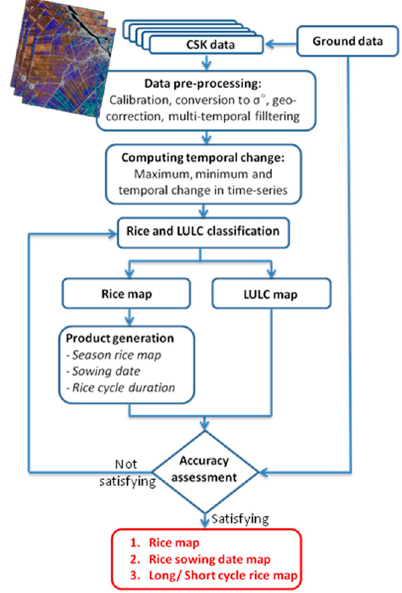
Figure 10. Flowchart of the rice monitoring method using multi-temporal CSK images.